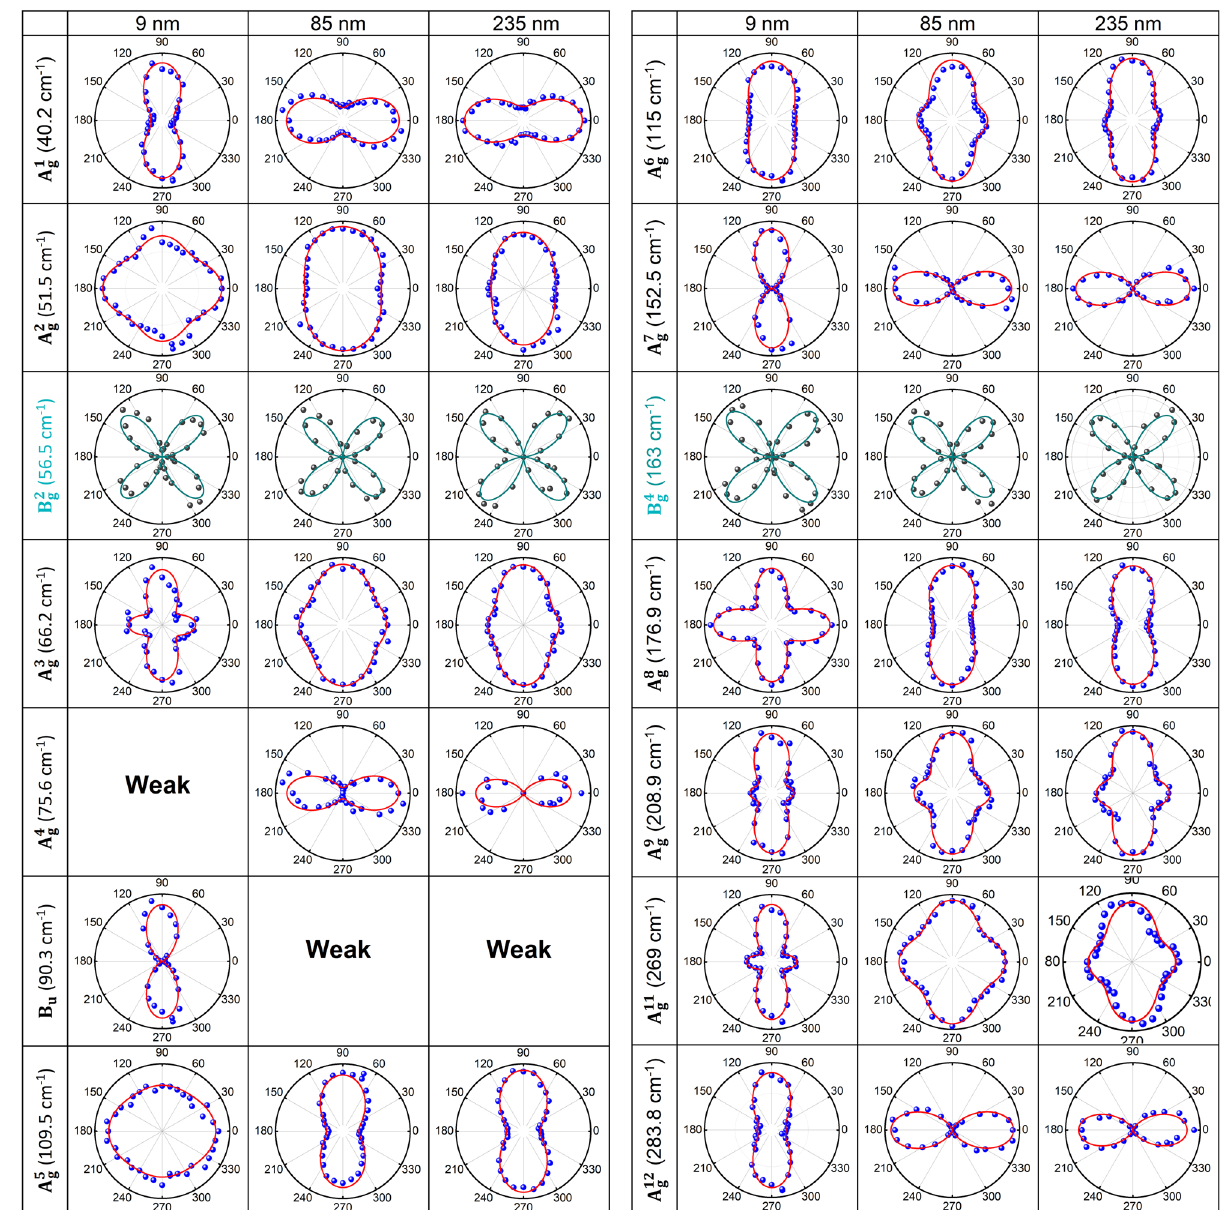
Figure 3. The Raman intensity polar plots and fitted curves of the observed 12 Raman-active modes from three different-thickness GaTe flakes in parallel polarization configuration. The blue (A g ) and the gray (B g ) dots are experimental values and the solid red (A g ) and dark cyan (B g ) lines are fitted